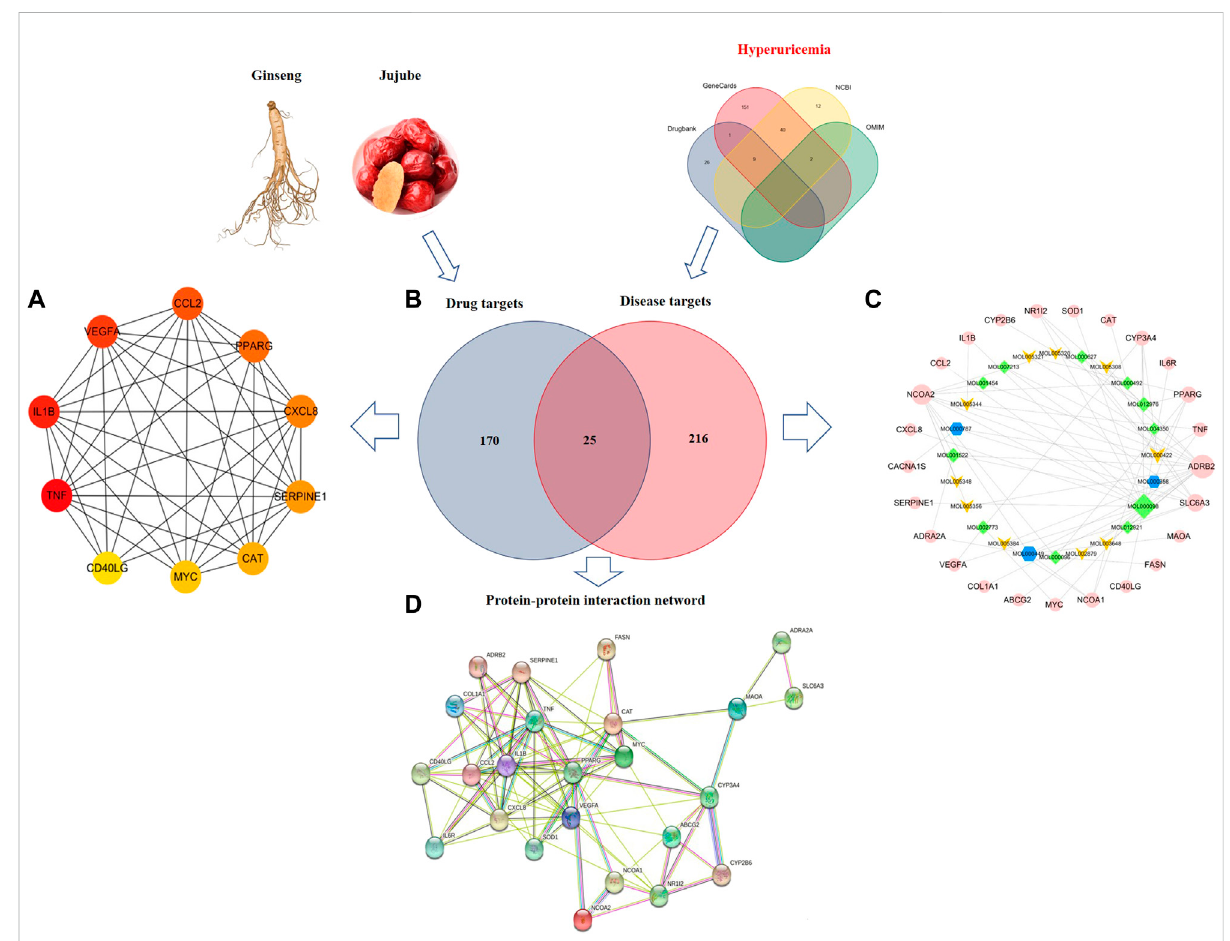
FIGURE 2 Visualization of the interaction targets between “ RG-ZJ ” components and the HUA disease diagram. Screened core targets (A) ; Venn diagram showing the numbers of the overlapped and speci fi c targets among the RG- ZJ herb pair (blue circle) and HUA (red circle) (B) ; Compound-target- pathway network of the “ RG- ZJ ” herb pair against HUA. The light green and yellow nodes are active ingredients of ZJ and RG, respectively. The pink nodes is the potential targets (C) ; Construction of protein interaction network (D)